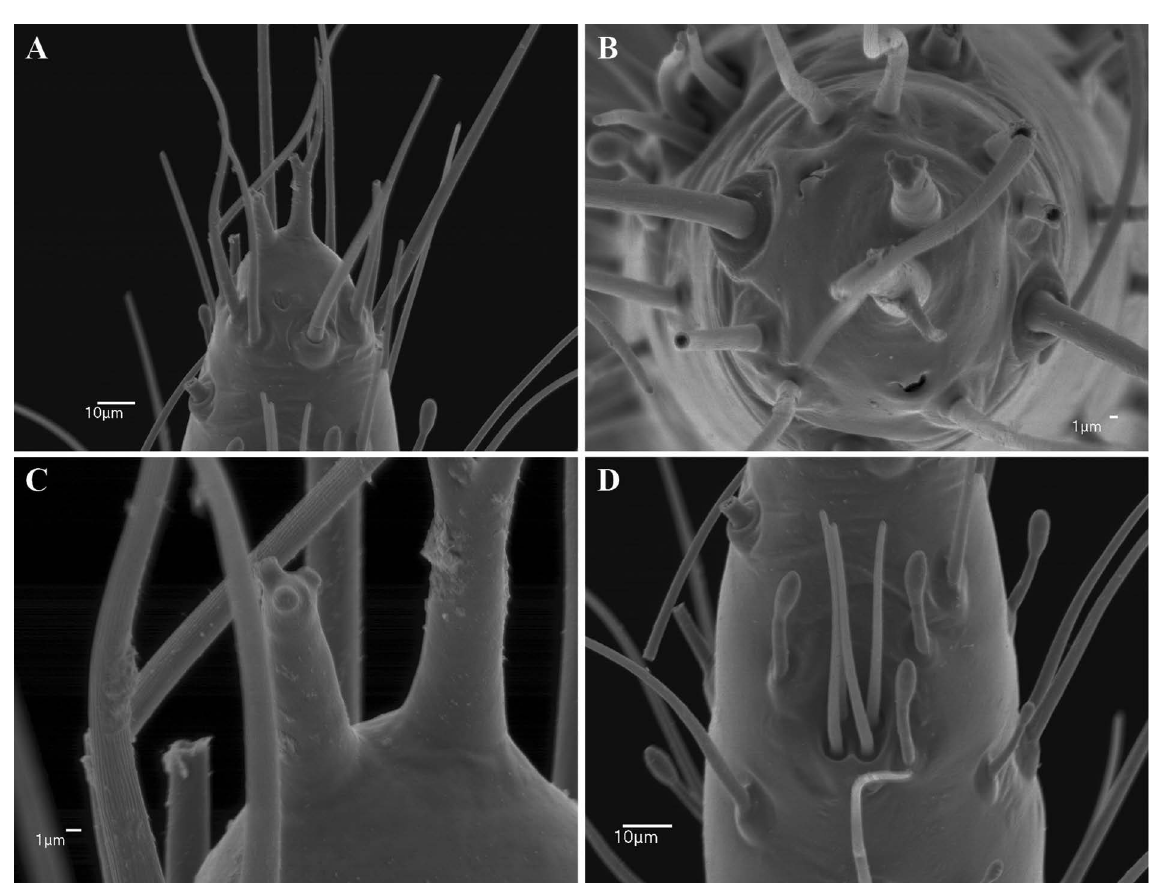
Fig. 107. Sarax bilua sp. nov. (AMCC [LP 5564]), antenniform leg I, ♀. A . Apex of distal article of tarsus showing claw and tarsal organ, lateral view. B . Claw and tarsal organ, frontal view. C . Tarsal organ. D . Rod sensilla and